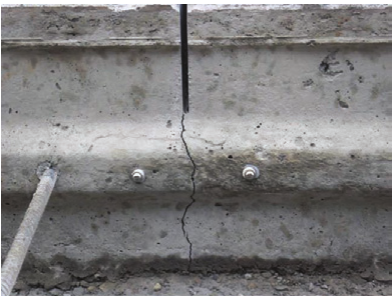
Fig. 1. Crack under transverse joint in JPCP, Province of Concepcion. 8:00 am – temperature at the surface of the pavement 13 °C